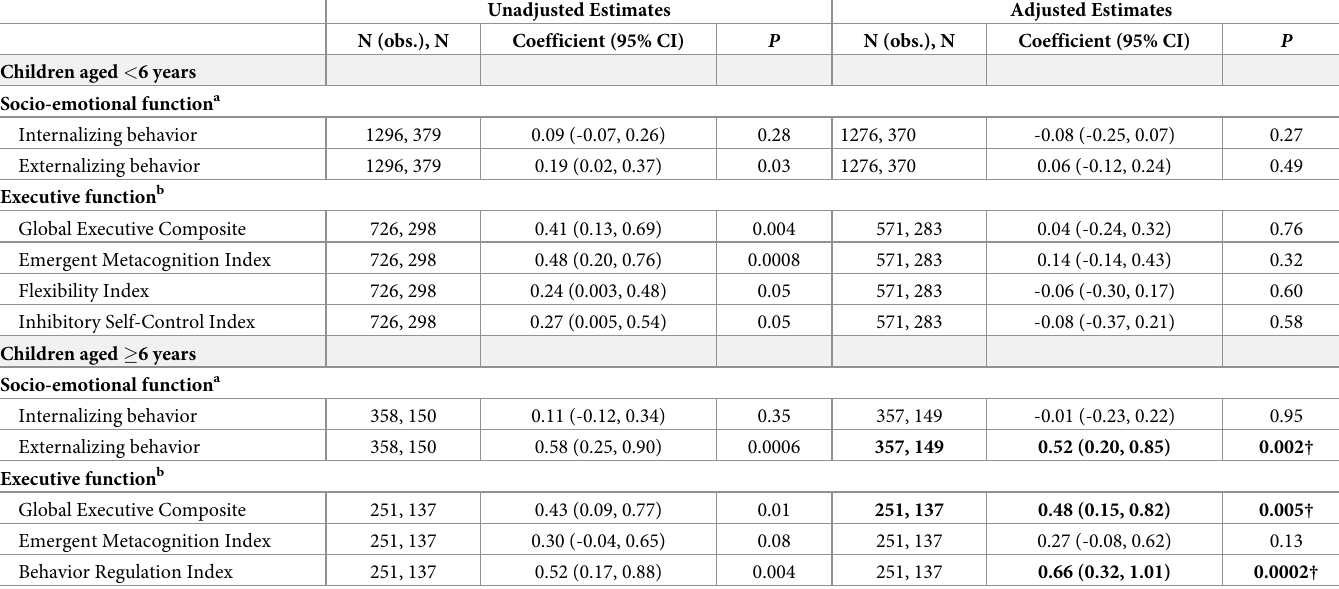
Table 2. Primary behavioral outcomes for children with severe malaria by acute kidney injury (AKI)